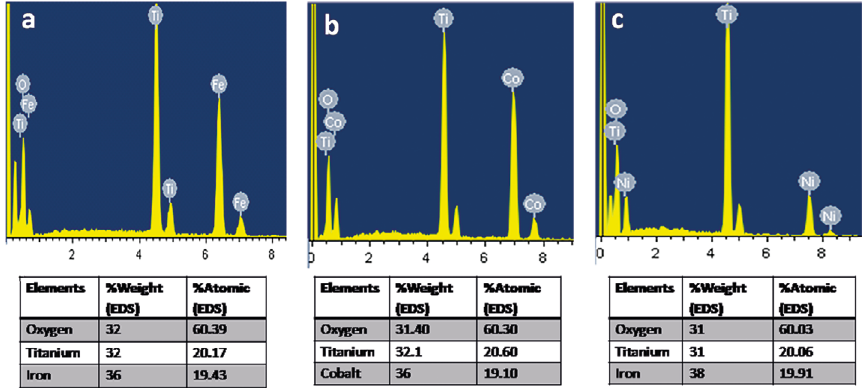
(b) CoTiO and (c) NiTiO obtained by solvo- 3 3 3